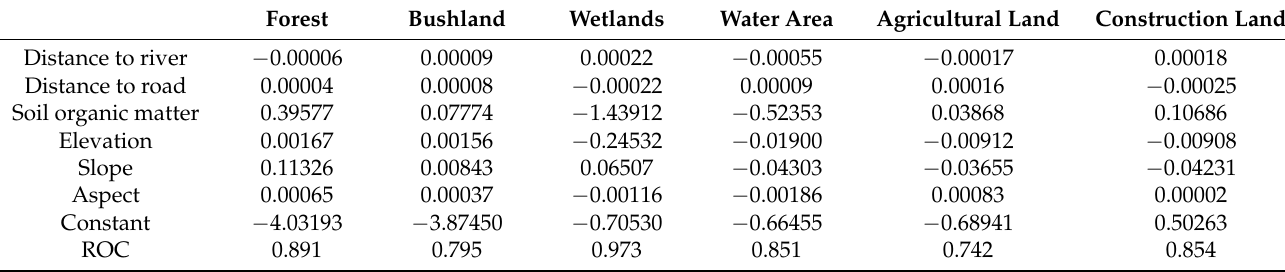
Figure 8. Spatial allocation of land resources in period 2. Table 4. Values of β from logistic regression.